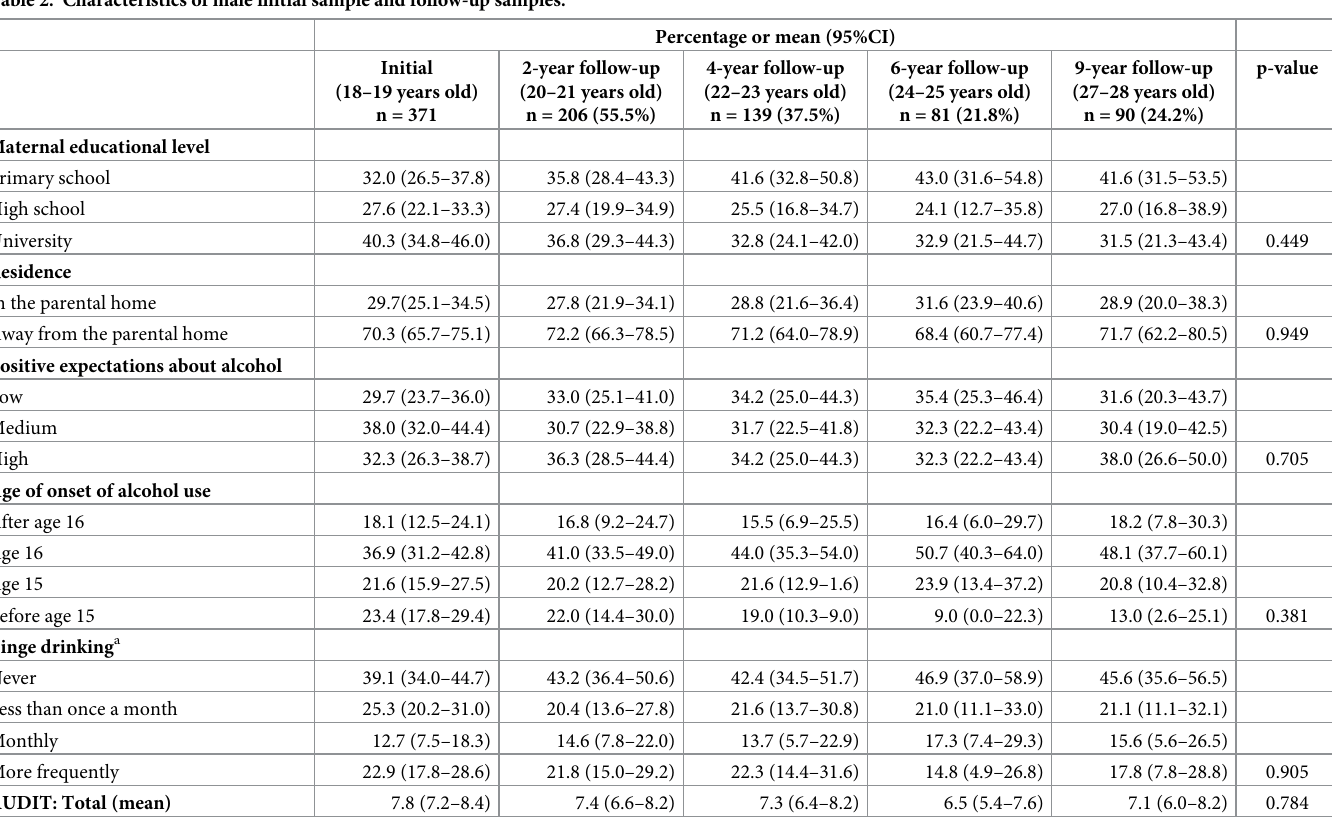
Table 2. Characteristics of male initial sample and follow-up